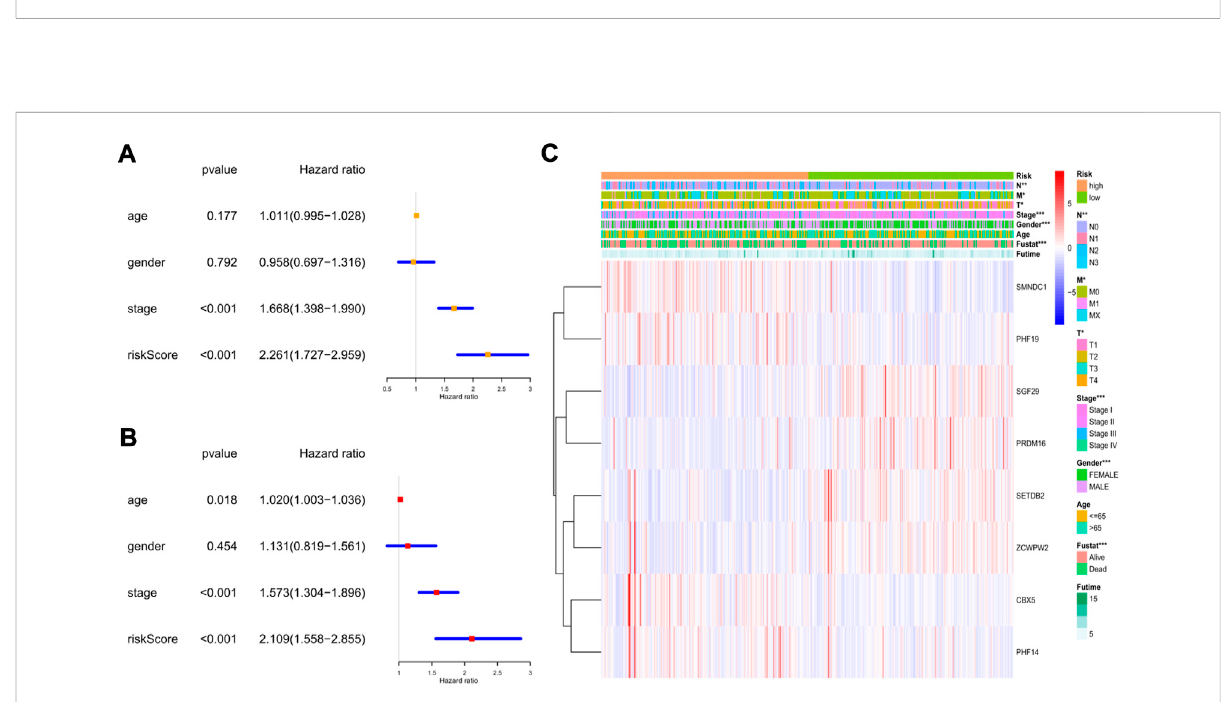
FIGURE 7 The independent prognostic value of the risk score in the training cohort. (A) The forest plot for univariate analysis; (B) The forest plot for multivariate analysis; (C) The heatmaps for the gene expression combined with clinical characteristics.